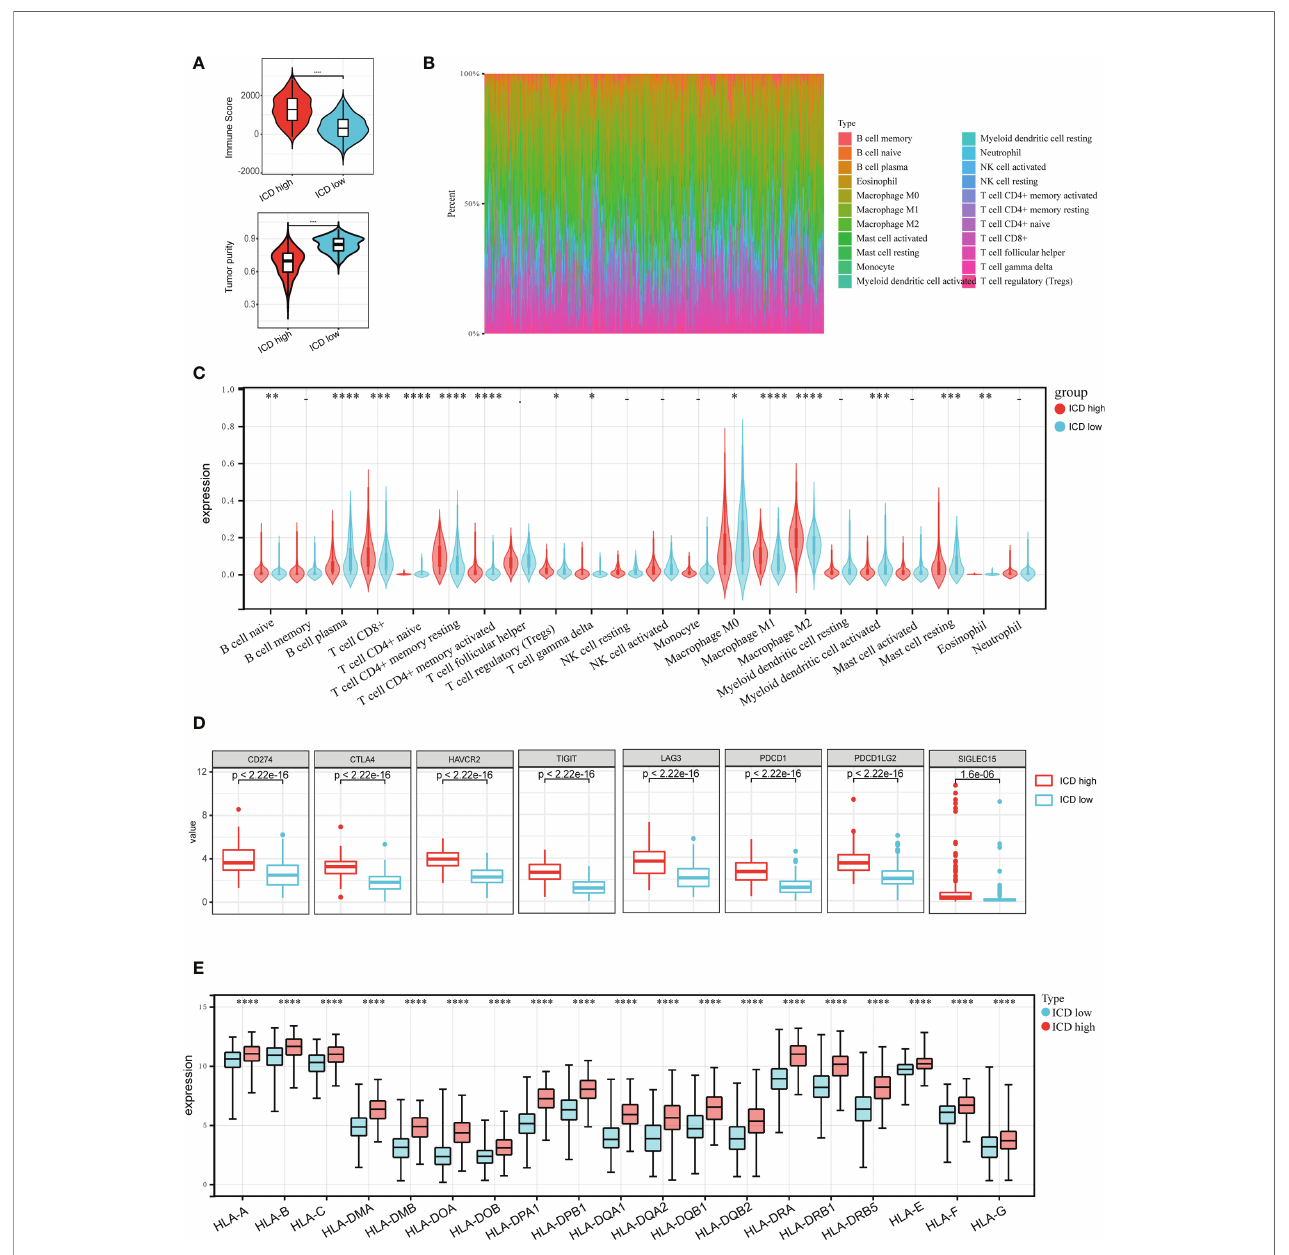
FIGURE 4 | Immune landscape of ICD-high and ICD-low subtypes. (A) Violin plots show the median, and quartile estimations for each immune score, and tumor purity score; (B) Relative proportion of immune in fi ltration in ICD-high and ICD-low subtypes; (C) Violin plot visualizes signi fi cantly different immune cells between different subtypes; (D, E) Box plots present differential expression of multiple immune checkpoints (D) , and HLA genes (E) between ICD-high and ICD-low subtypes. *P < 0.05, **P < 0.01, ***P < 0.001, and ****P <